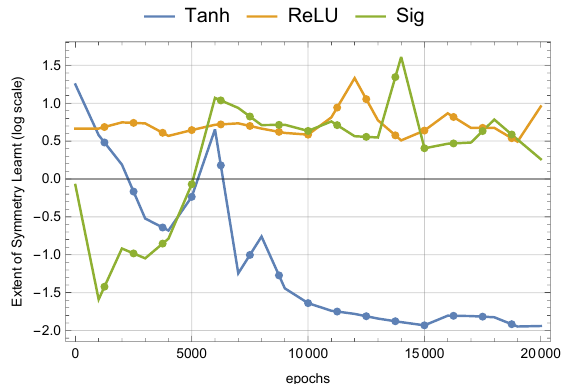
Figure 12 . Discrete isometries of the quartic K3 surface defined in (8.2) being learnt. The plot shows the extent of learning given by (8.1) for the symmetry of the K3 surface described in (8.4). We observe similar behavior for other symmetries of the class